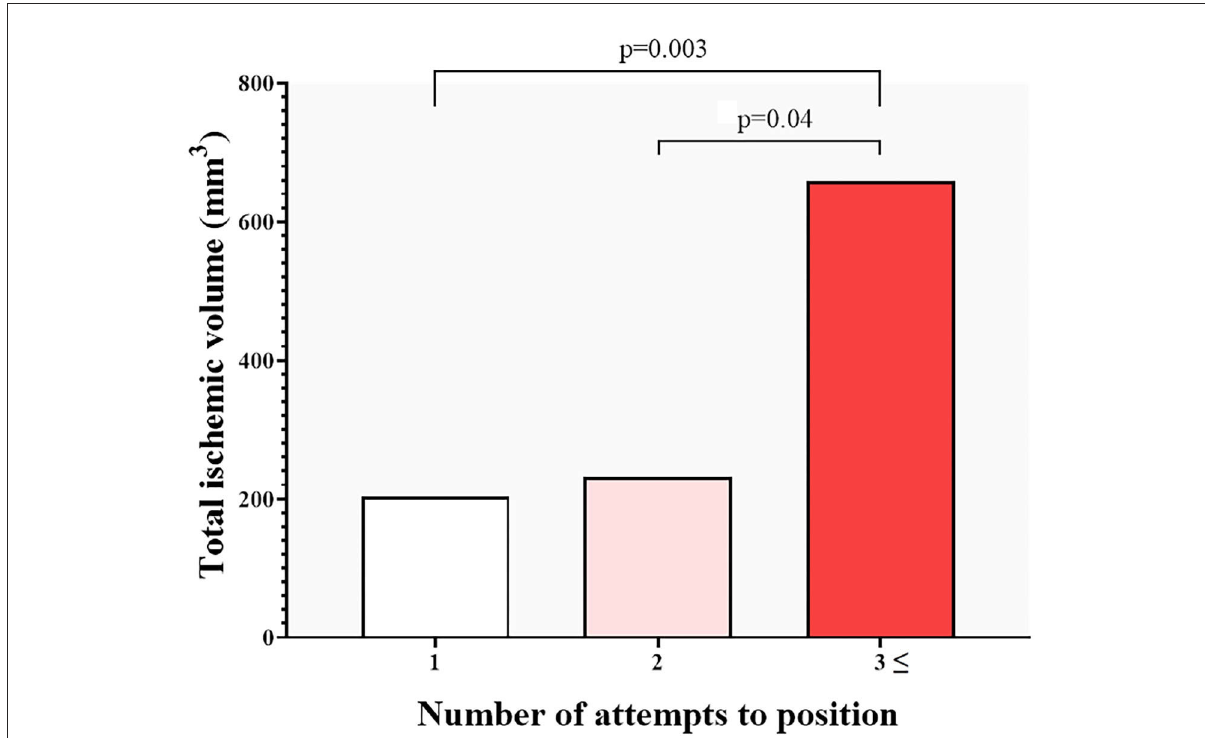
FIGURE4 Total ischemic volume on MRI and the number of TAVI positioning attempts. The number of procedural manipulations shows a strong correlation with the ischemic lesion volume (ILV), Three or more positioning attempts of the device resulted in significantly increased ILV.